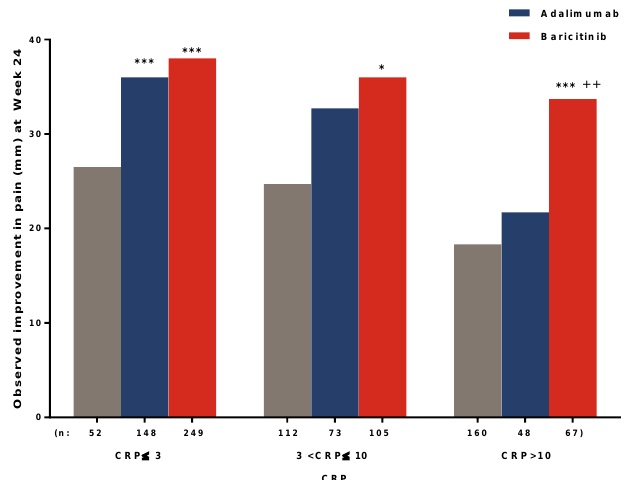
Figure 3. Pain improvement by remaining inflammation (CRP, mg/L) at Week 24. * p ≤ 0.05, *** p ≤ 0.001 vs. placebo; †† p ≤ 0.01 vs. adalimumab. Abbreviations: CRP = C-reactive protein.